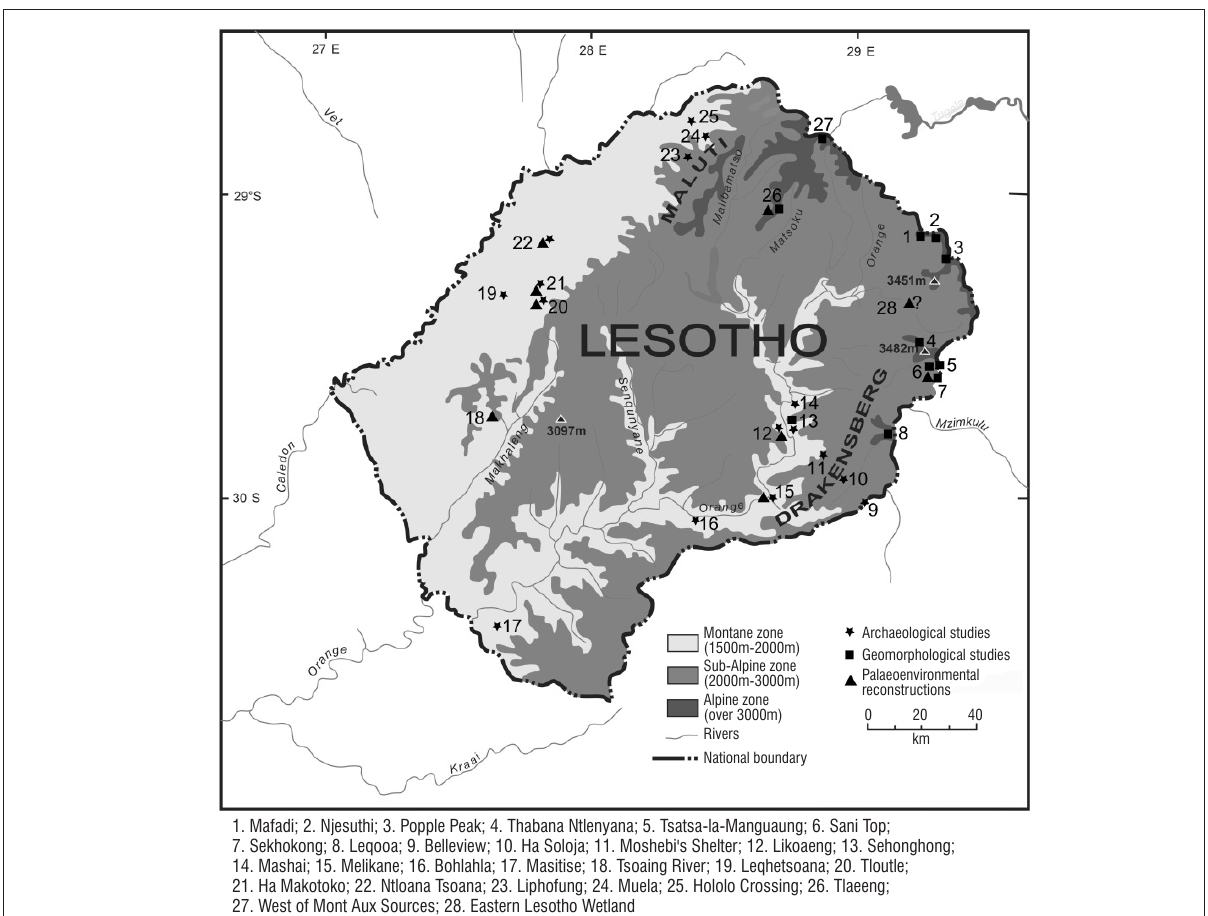
Figure 1: The location of archaeological, geomorphological and palaeoenvironmental study sites in Lesotho from which published palaeoclimatic inferences have been